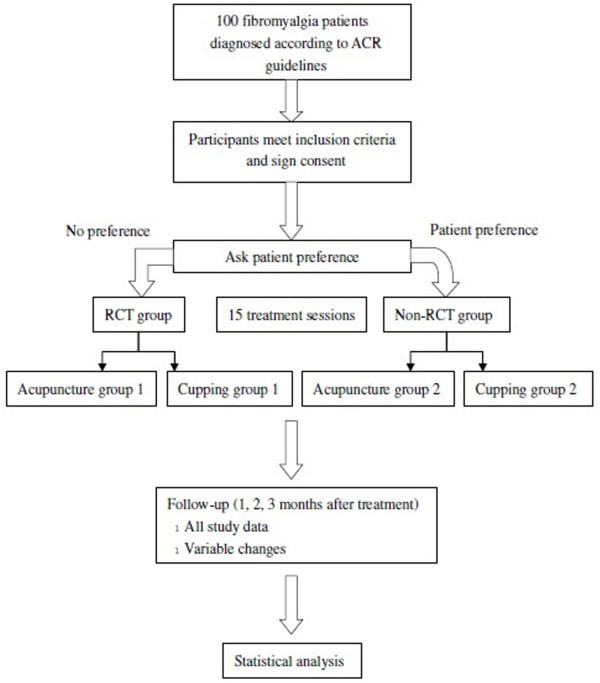
Study flow chart.